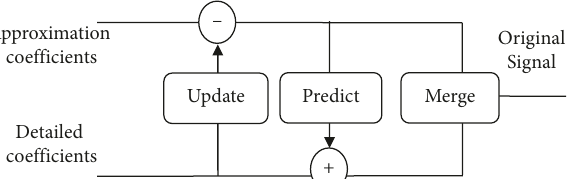
Figure 2: Inverse lifting wavelet transform.